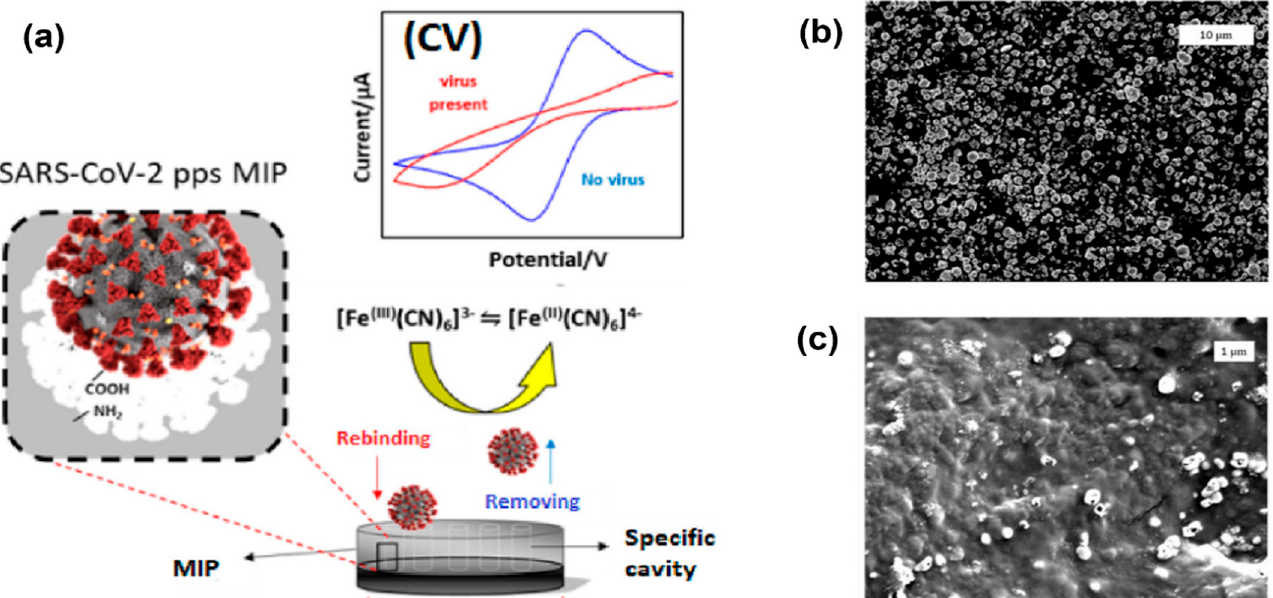
Figure 4. Electropolymerization technique using molecular imprinted polymer (MIP) to enhance the surface area and sensitivity of electrodes. ( a ) Imprinted MIP is electrodeposited on a screen-printed carbon electrode to create enhanced anodic/cathodic currents during cyclic voltammetry measurements. ( b ) Electrode surface before polymerization. ( c ) Electrode surface after polymerization, indicating polymer modification and a change in topography [59].